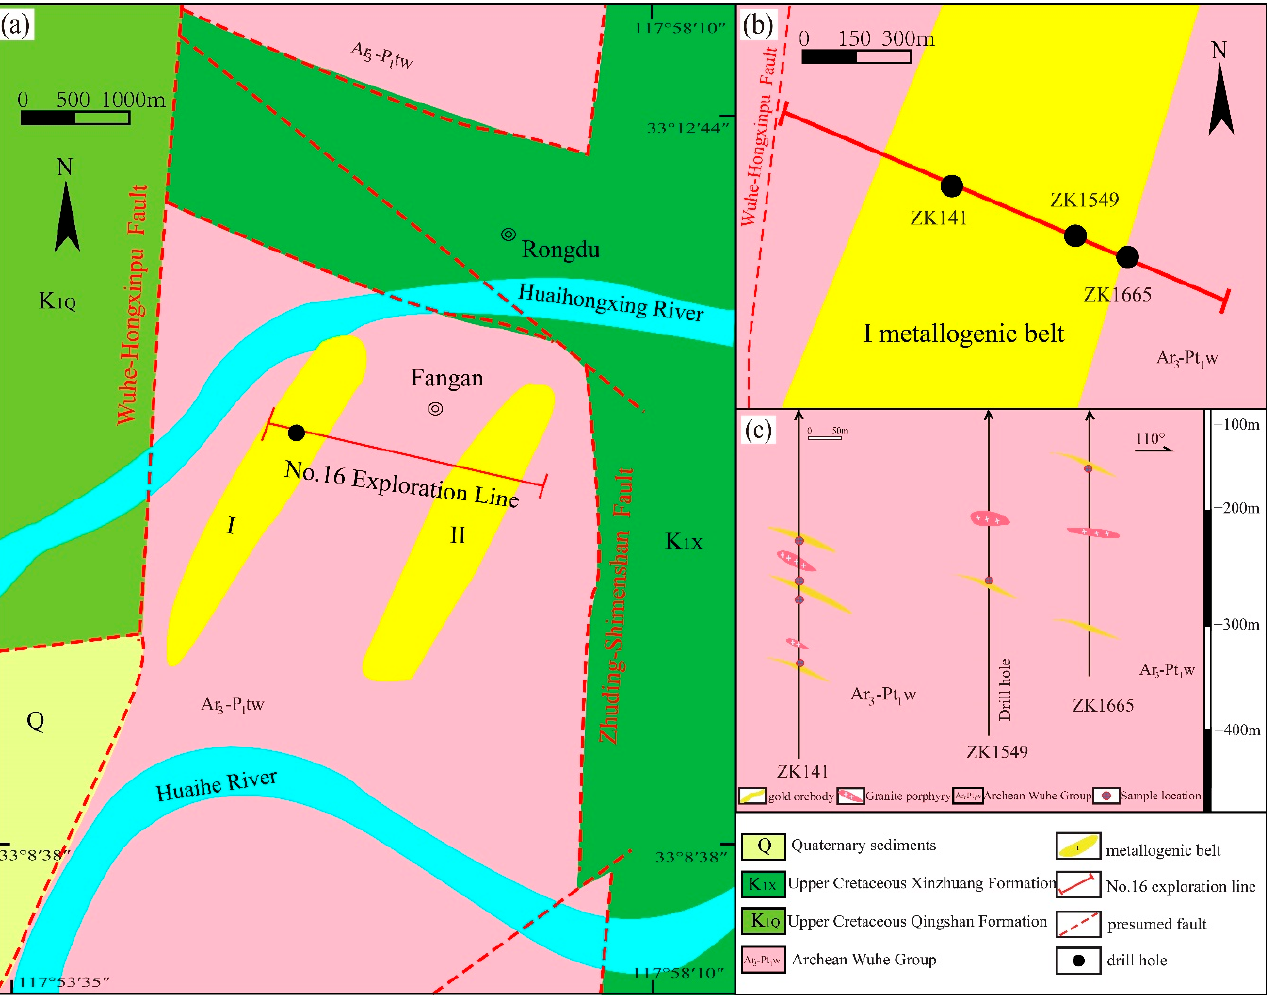
Figure 3. Ore features of Fang’an gold deposit: ( a ) polymetallic sulfide ore; ( b ) pyritohedron struc- ture pyrite; ( c ) pyrite in quartz vein; ( d ) carbonate, quartz, and muscovite alteration in pyrite-quartz altered rocks. Py—pyrite; Qz—quartz; Ser—sercite; Cal—calcite.